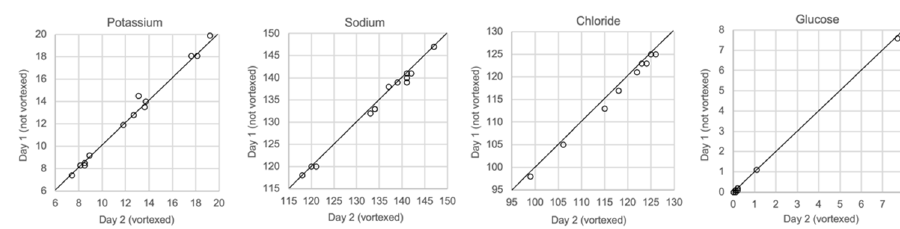
Figure 9. Comparison of samples not vortexed (day 1) and vortexed (day 2), n = 13.